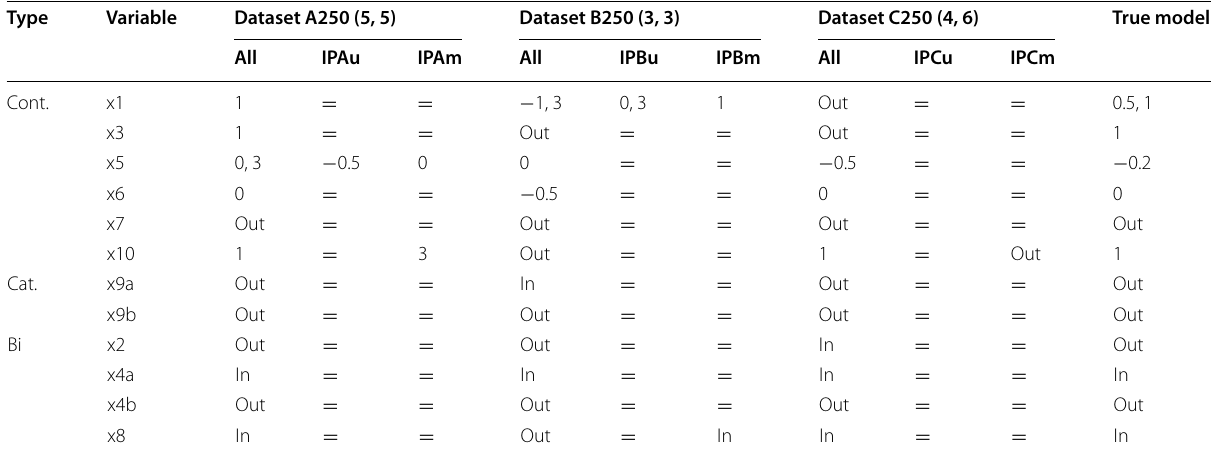
Table 3 Data A250, B250, and C250. Selected MFP models with complete data (“all”) and after removal of IPs identified from the univariable (IPXu) and multivariable (IPXm) diagnostic analyses. The number of IPs identified univariable and multivariable, respectively, are shown in parentheses. “ ” is used if the power selected agreed to the power from all data =